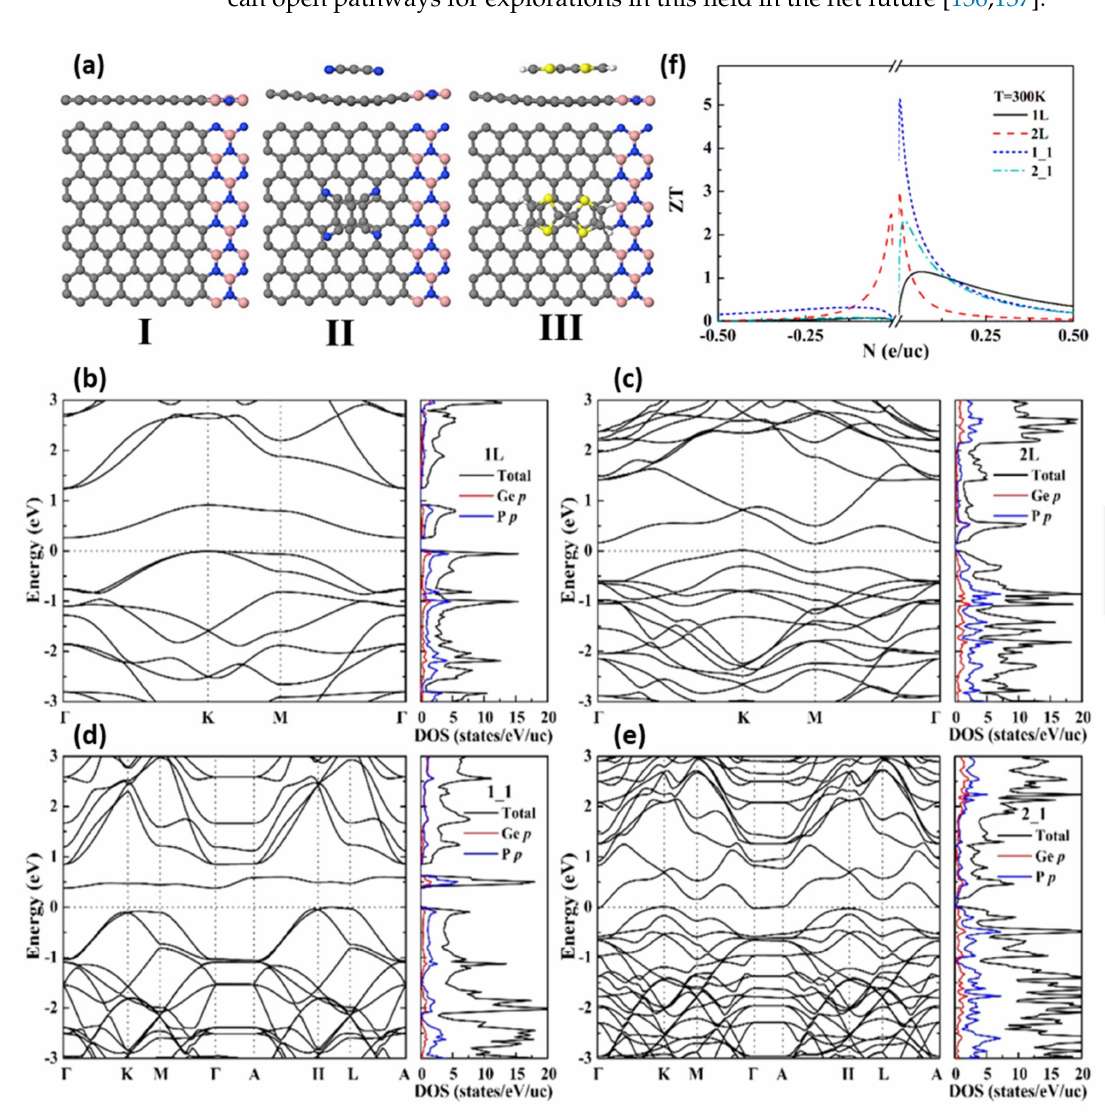
Figure 9. ( a ) Side and top views of graphene/2D h-BN heterostructures (I) without doping, (II) doped by electron acceptor-TCNE, and (III) doped by electron donor-TTF [140] (Reprinted with permission from IOP Publishing, Ltd., Copyright © 2015). ( b , c ) Calculated band structure and corresponding DOS for 1L and 2L GeP 3 , respectively. ( d , e ) Calculated band structure and corresponding DOS for GeP 3 /h-BN m_1 heterostructures (m = 1 and 2), respectively. ( f ) ZT values for 1L and 2L GeP 3 , as well as for GeP 3 /h-BN m_1 heterostructures (m = 1 and 2) [141] (Reprinted with permission from American Chemical Society, Copyright ©